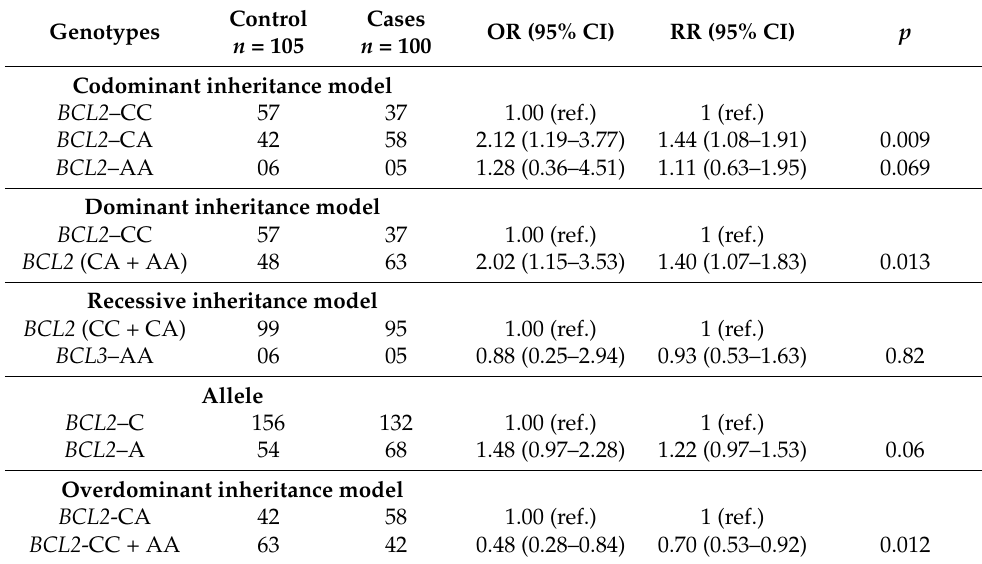
Table 4. Association of BCL2-938 C > A gene variation in cases and controls.